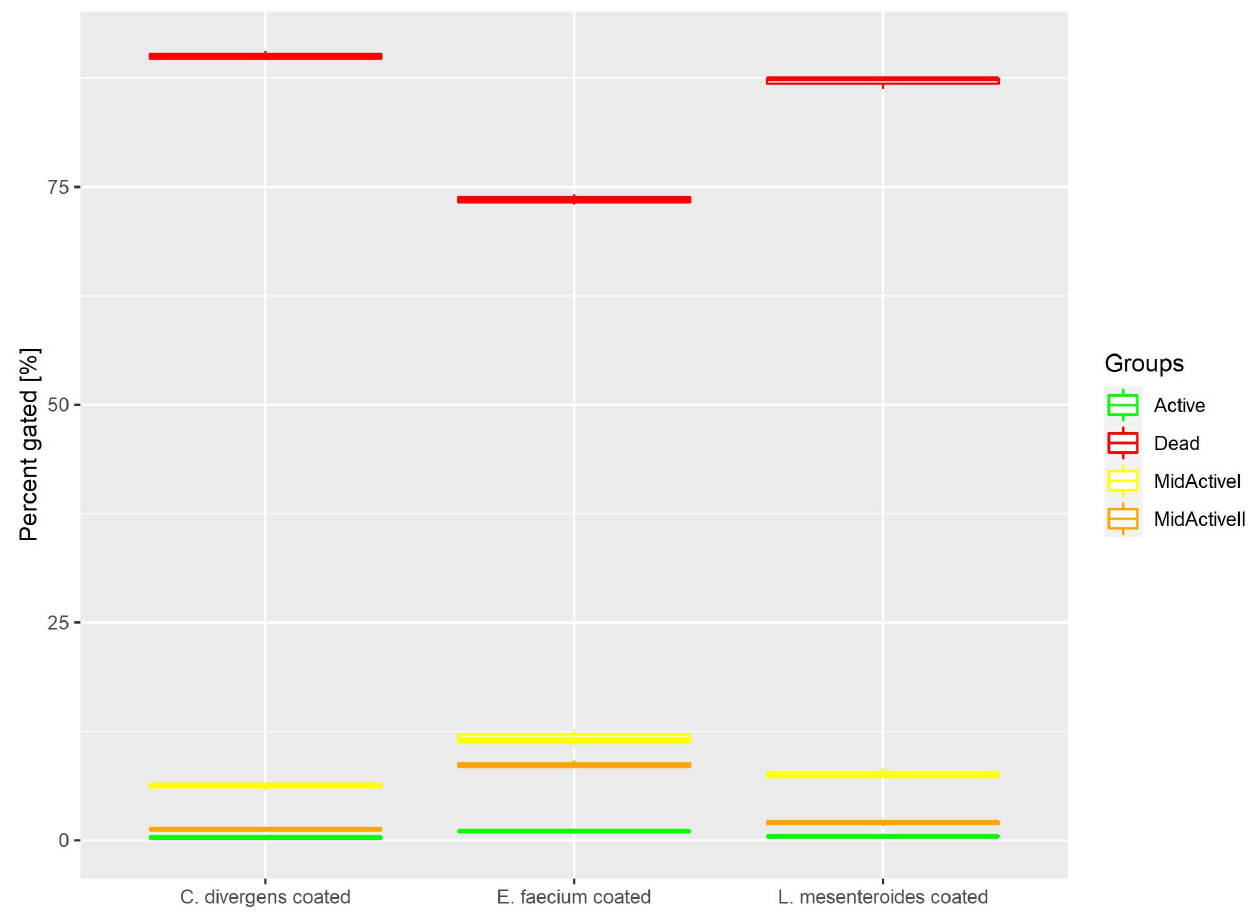
Figure 8. Cell subpopulation percentages in dried samples after coating.